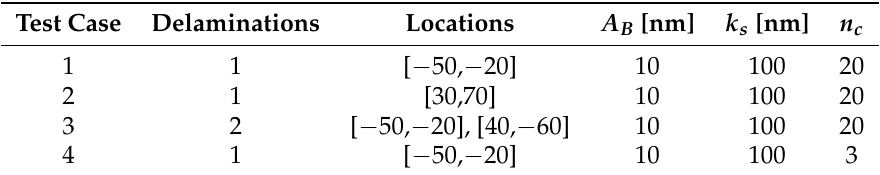
Table 3. Specifications of the numerical test